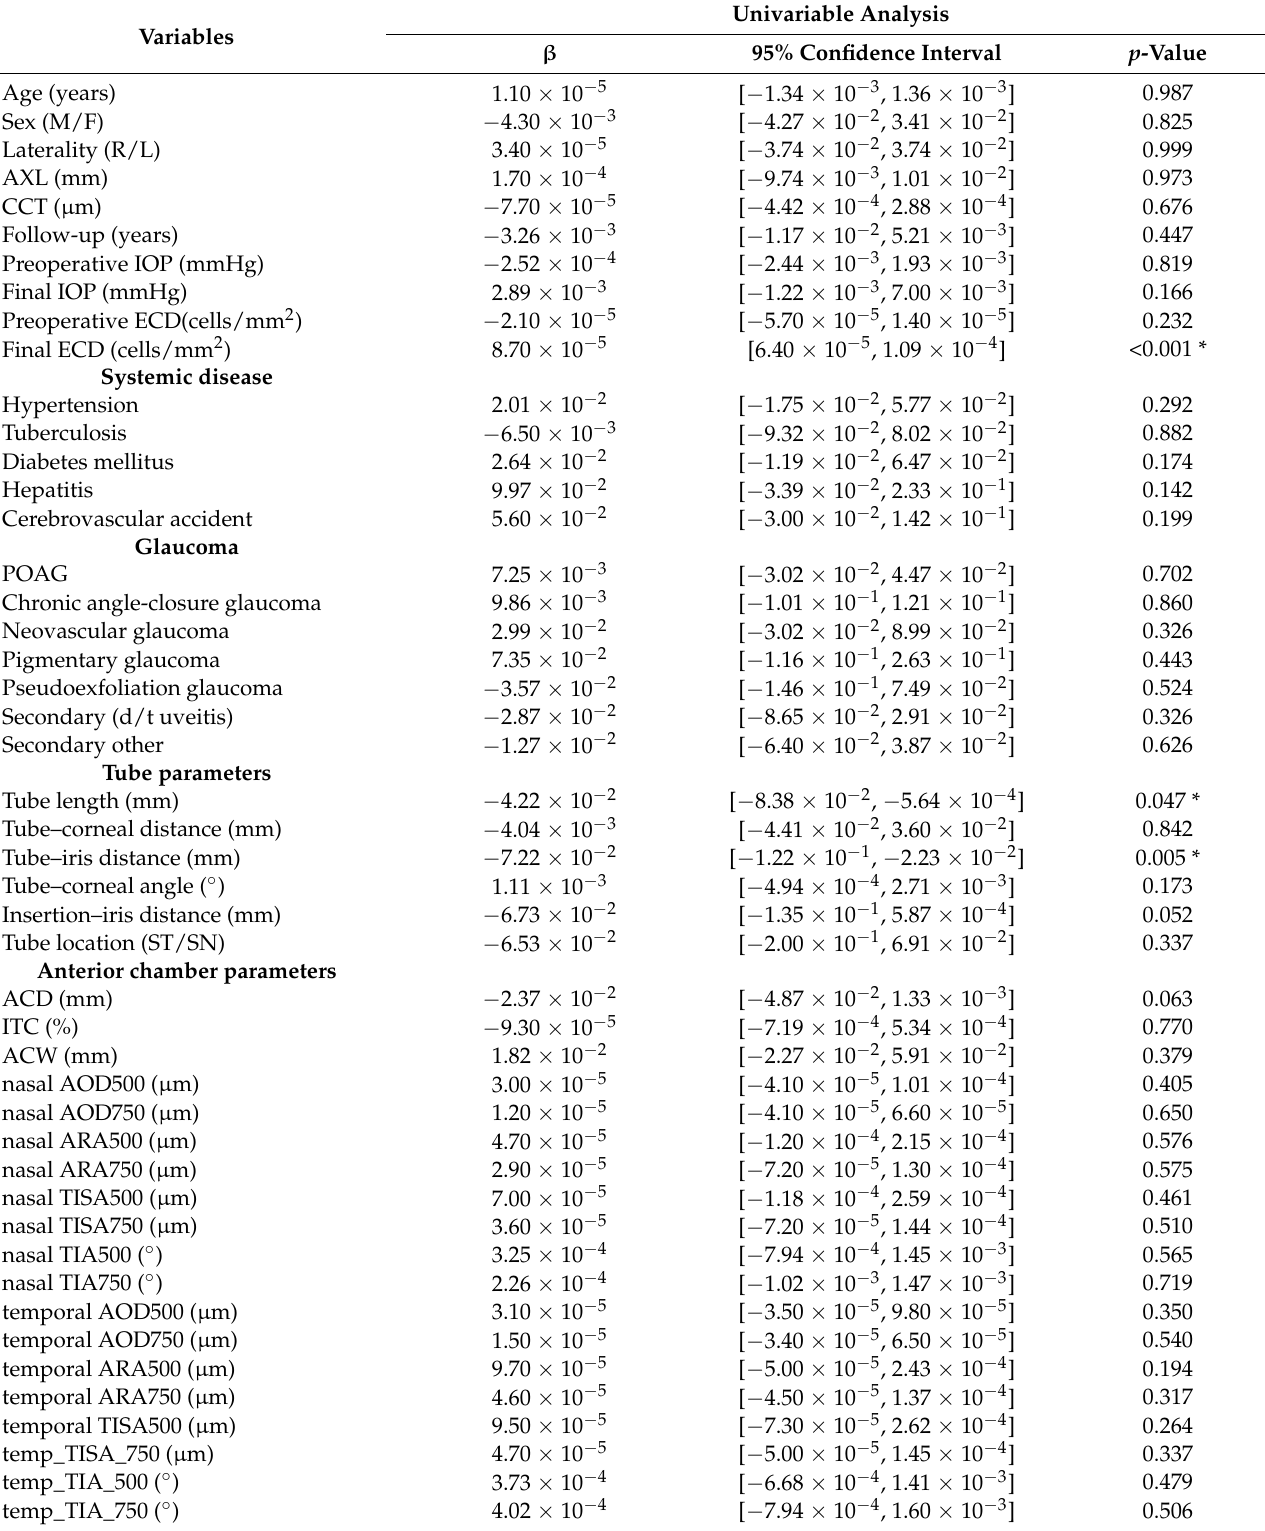
Table 3. Univariable linear regressions regarding associations with ECD change